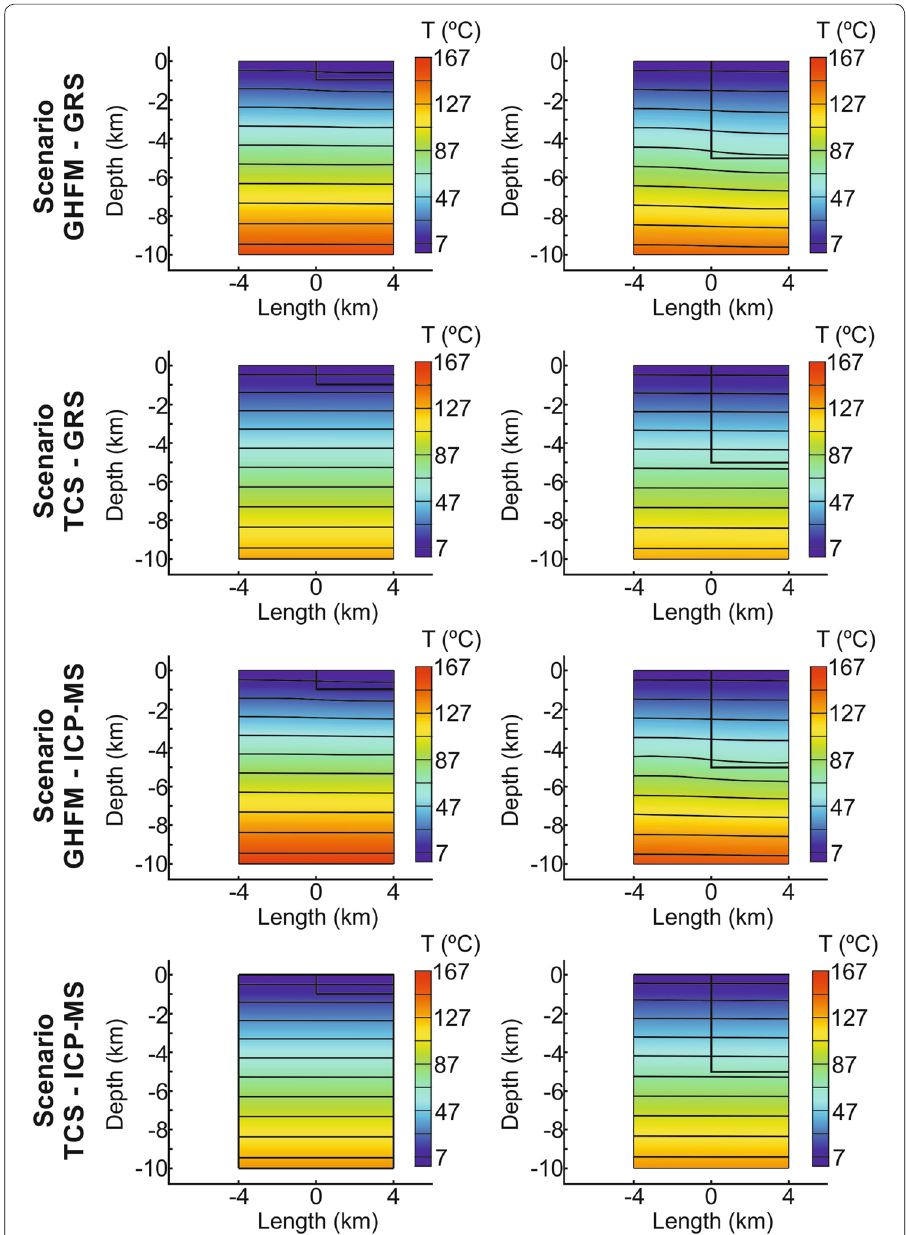
Fig. 7 2D steady-state simulations of the present-day temperature distribution at